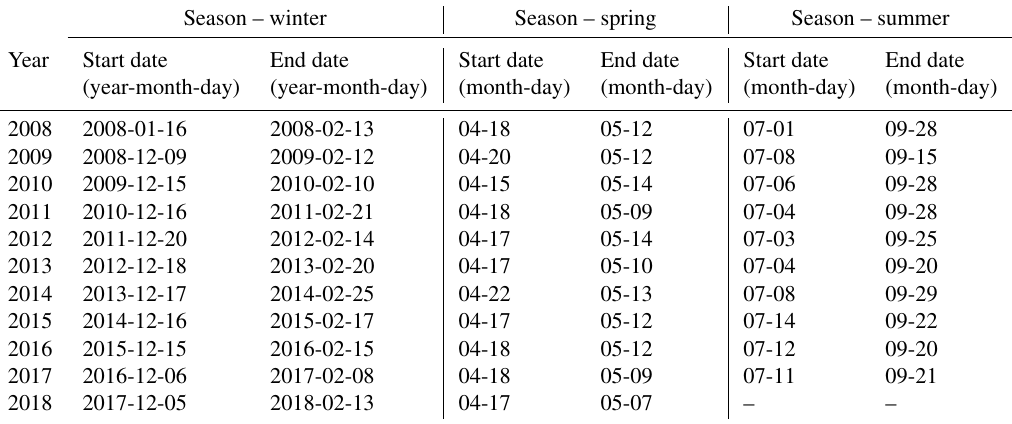
Table A1. Dates used for chemistry investigation . The dates are the start and end dates for observations within the seasons classified as winter, spring, and summer, respectively. Note that BC only includes dates from 2008 to